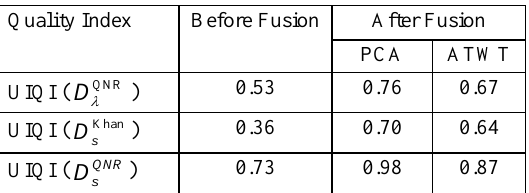
Table 1. Numerical results of assessment for object disappearances